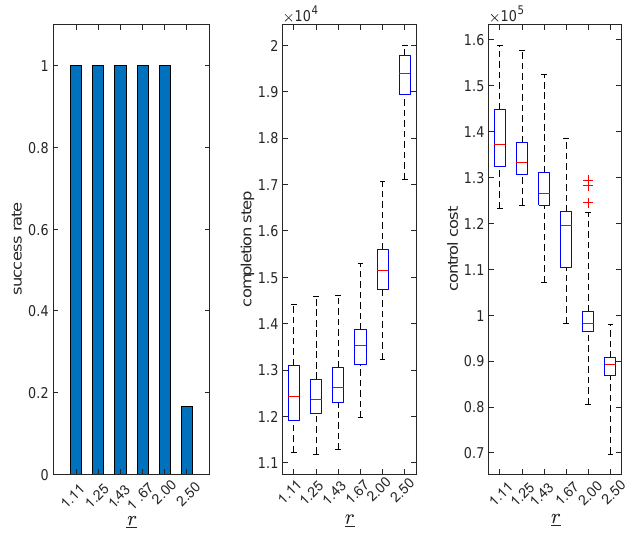
Figure 18. The algorithm performance with respect to the variations of r .